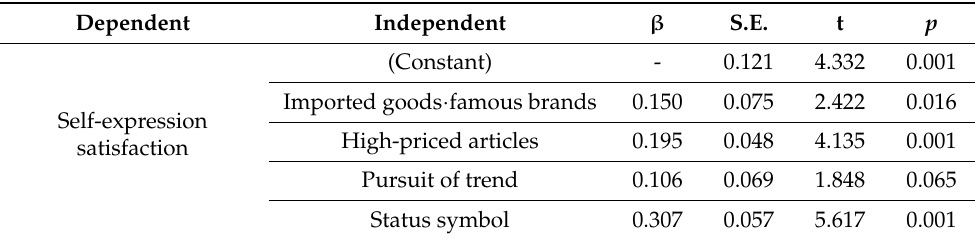
Table 6. Relation between conspicuous consumption tendency and self-expression satisfaction of Gen Z through SNS activities.